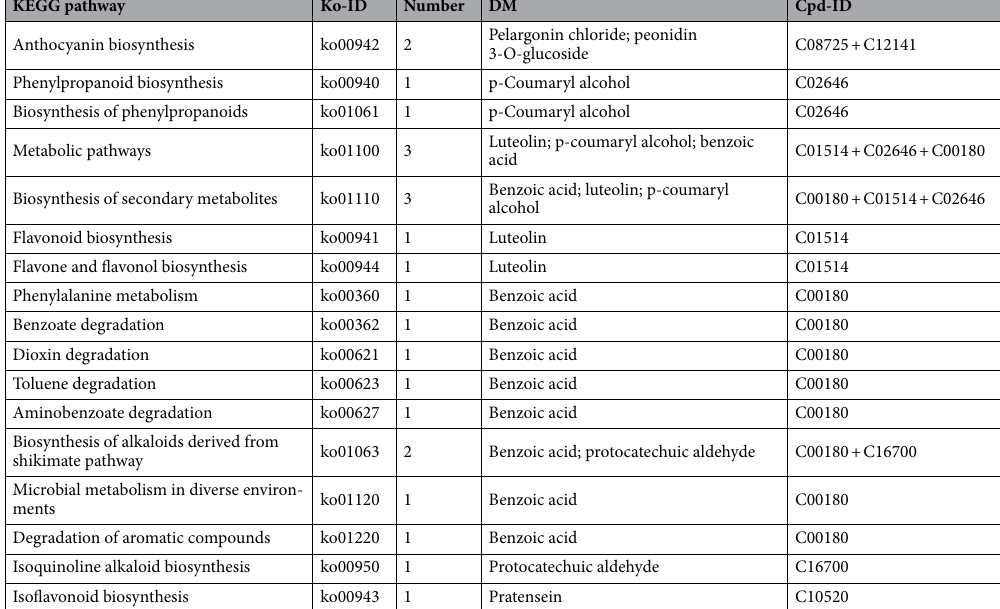
Table 3. The categories of 12 DMs-annotated KEGG pathways. Ko-ID = ID of KEGG pathway, Number = the number of metabolites that can be annotated to the corresponding KEGG pathways, Cpd-ID = Number of compound in